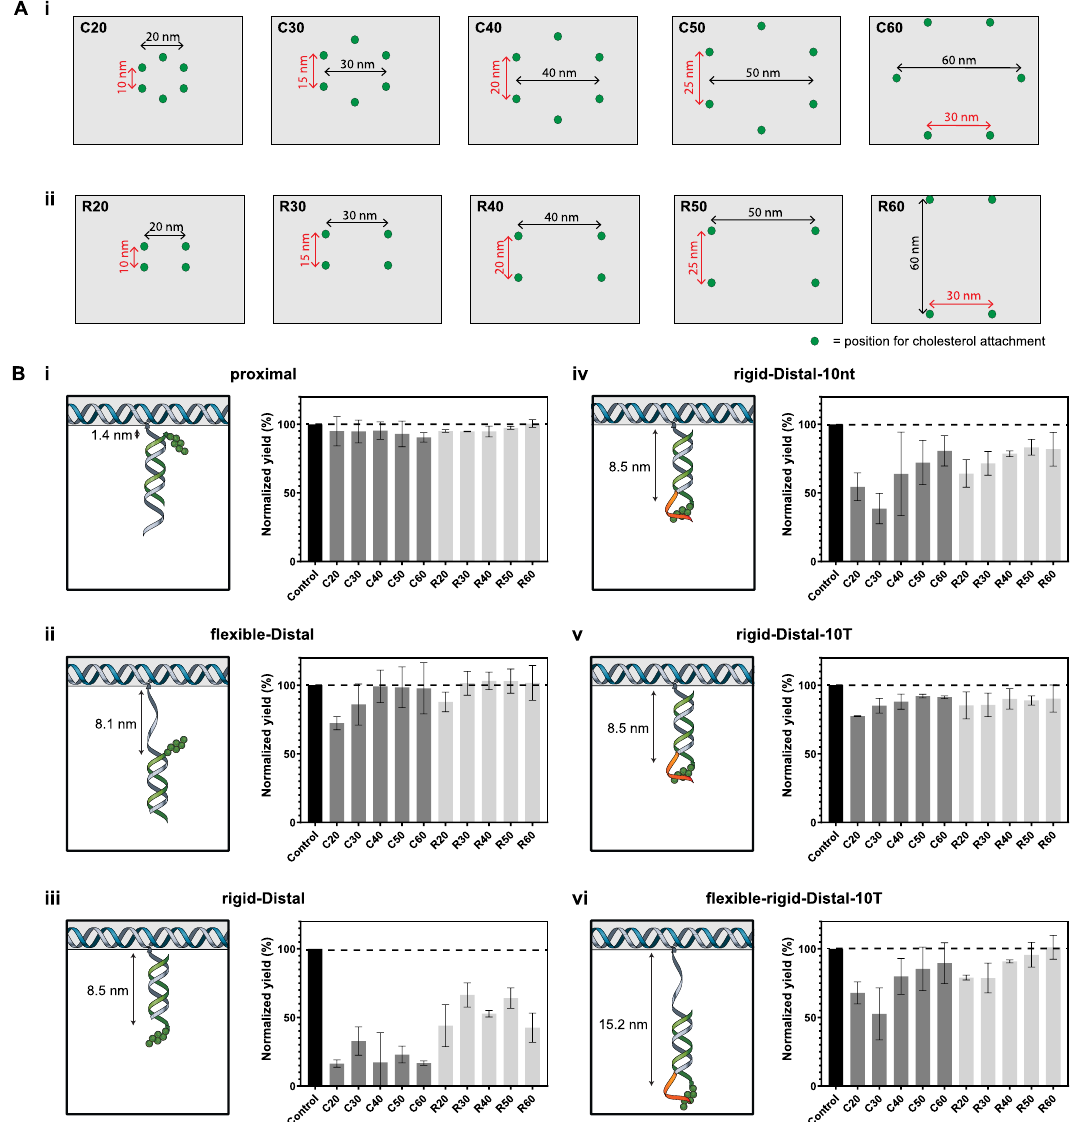
Figure 2. Systematic study of the aggregation of the DOT. ( A ). Top view of the DOT showing the position of cholesterol attachment for the different configurations tested. ( i ) Circular configuration. ( ii ) Rectangular configuration. ( B ). Schematic of the different spacer designs tested and their normalized yield of folding for the different configurations. A lower yield signifies more aggregation. ( i ) Proximal. ( ii ) Flexible-distal. ( iii ) Rigid-distal. ( iv ) Rigid-distal-10nt. ( v ) Rigid-distal-10T. ( vi ) Flexible-rigid-distal-10T. Staple extension from DOT: grey. Cholesterol strand: green. Overhang: orange. Table 1. Handle separation for cholesterol attachment in the circular configuration. The maximum separation is across the diameter of the circular configuration while the minimum separation is between adjacent cholesterols.